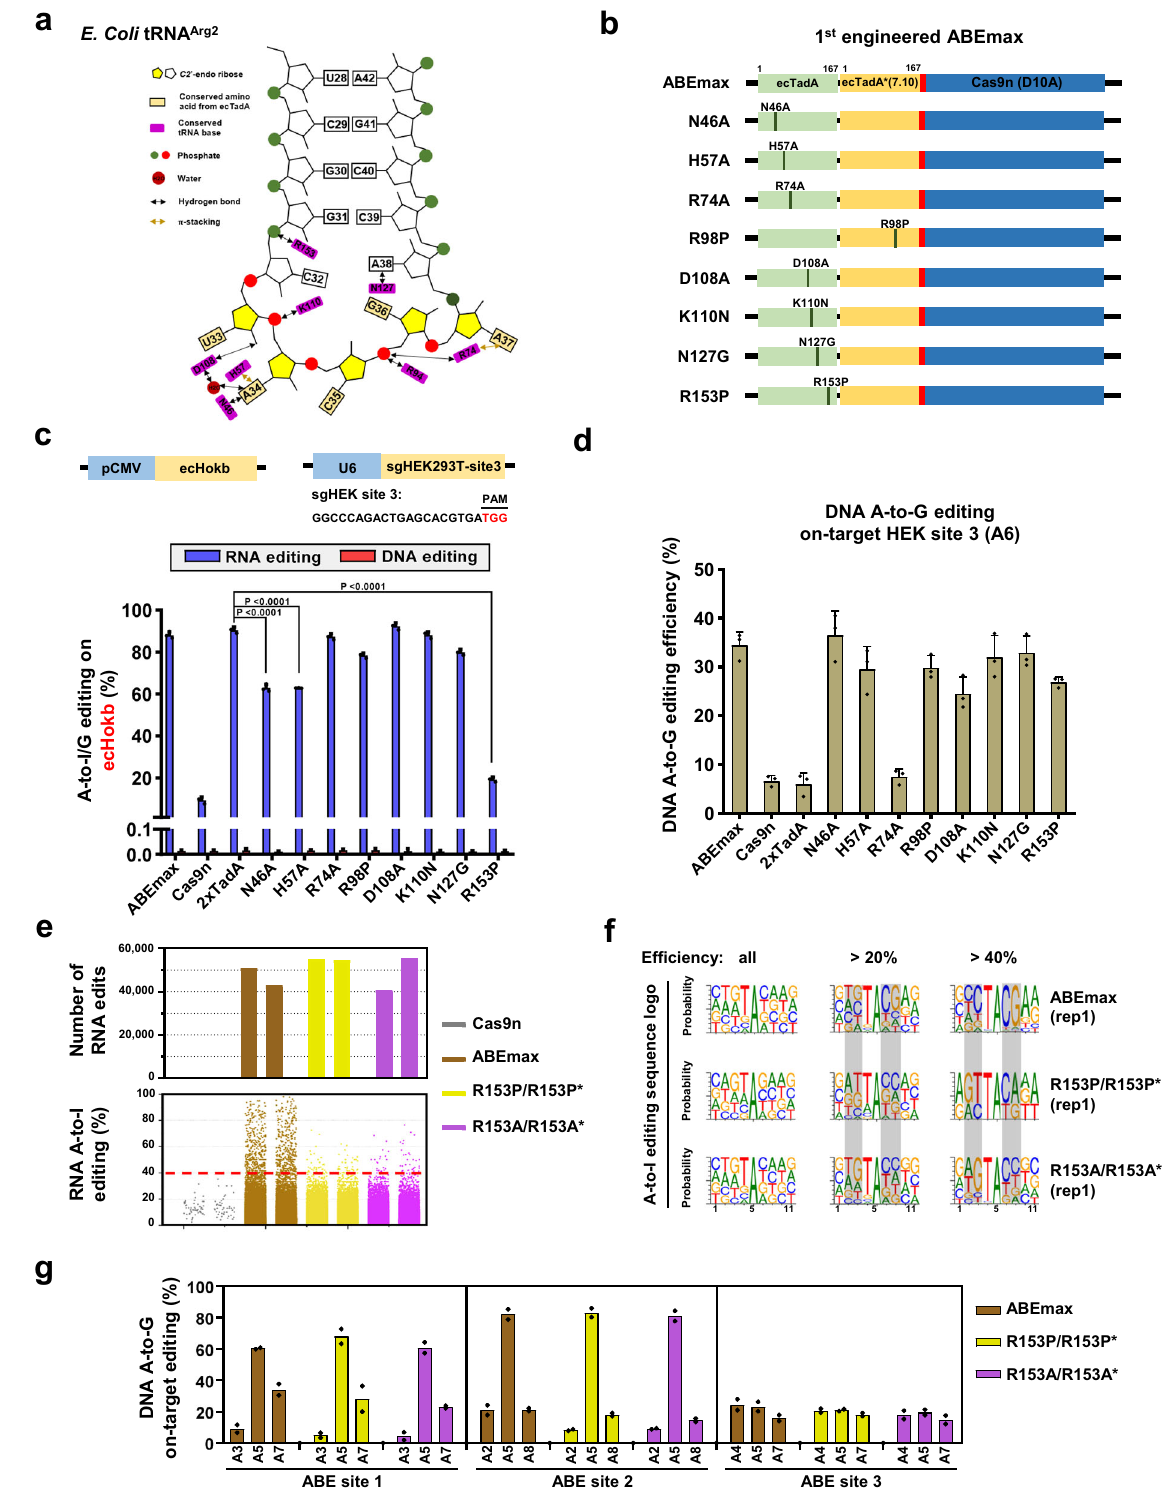
comparable with ABEmax (Fig. 1e by MuTect2; a bit lower by HaplotypeCaller in Supplementary Fig. 4d), and R153P variant induced even more RNA edits, which was excluded in further test (Supplementary Fig. 4e). In fact, R153P/R153P * and R153A/ R153A * was tested after the observation of high RNA A-to-I edits induced by R153P variant. Sequence logos derived from highly edited adenines (> 20%) showed that the preference of